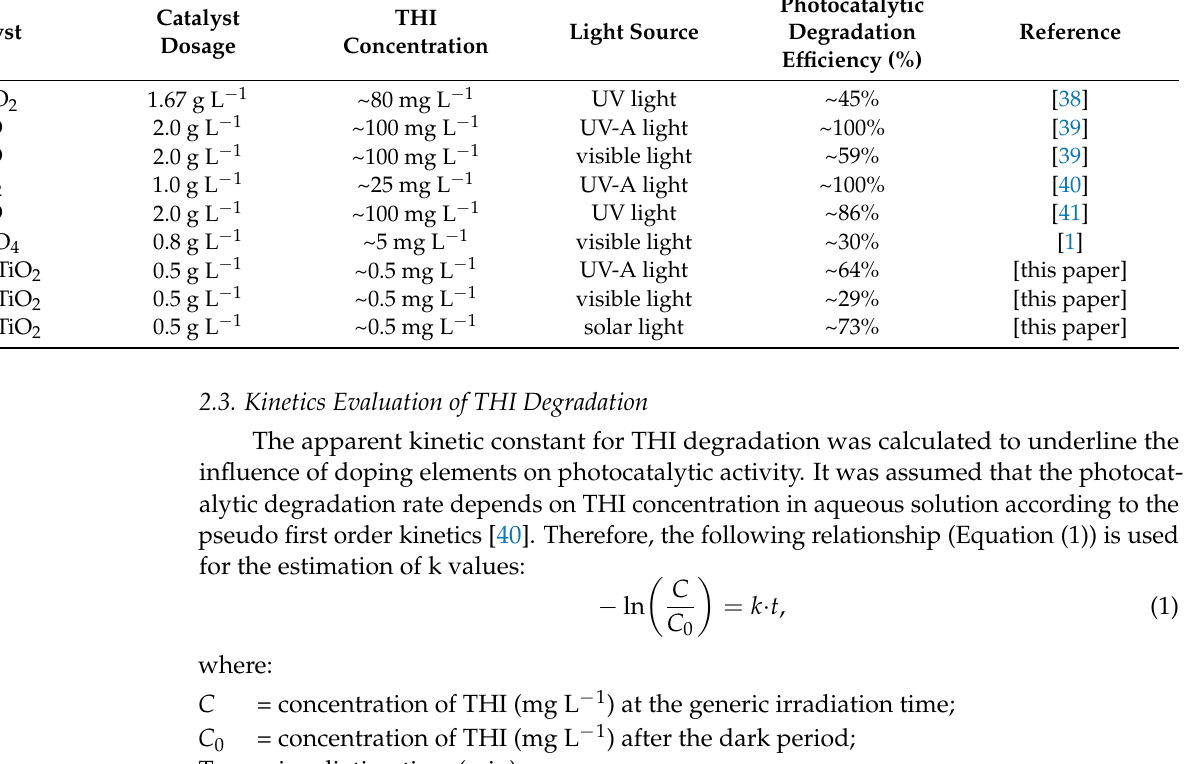
Table 2. Comparison with the available literature dealing with the photocatalytic degradation of THI. Catalyst Catalyst Dosage Concentration